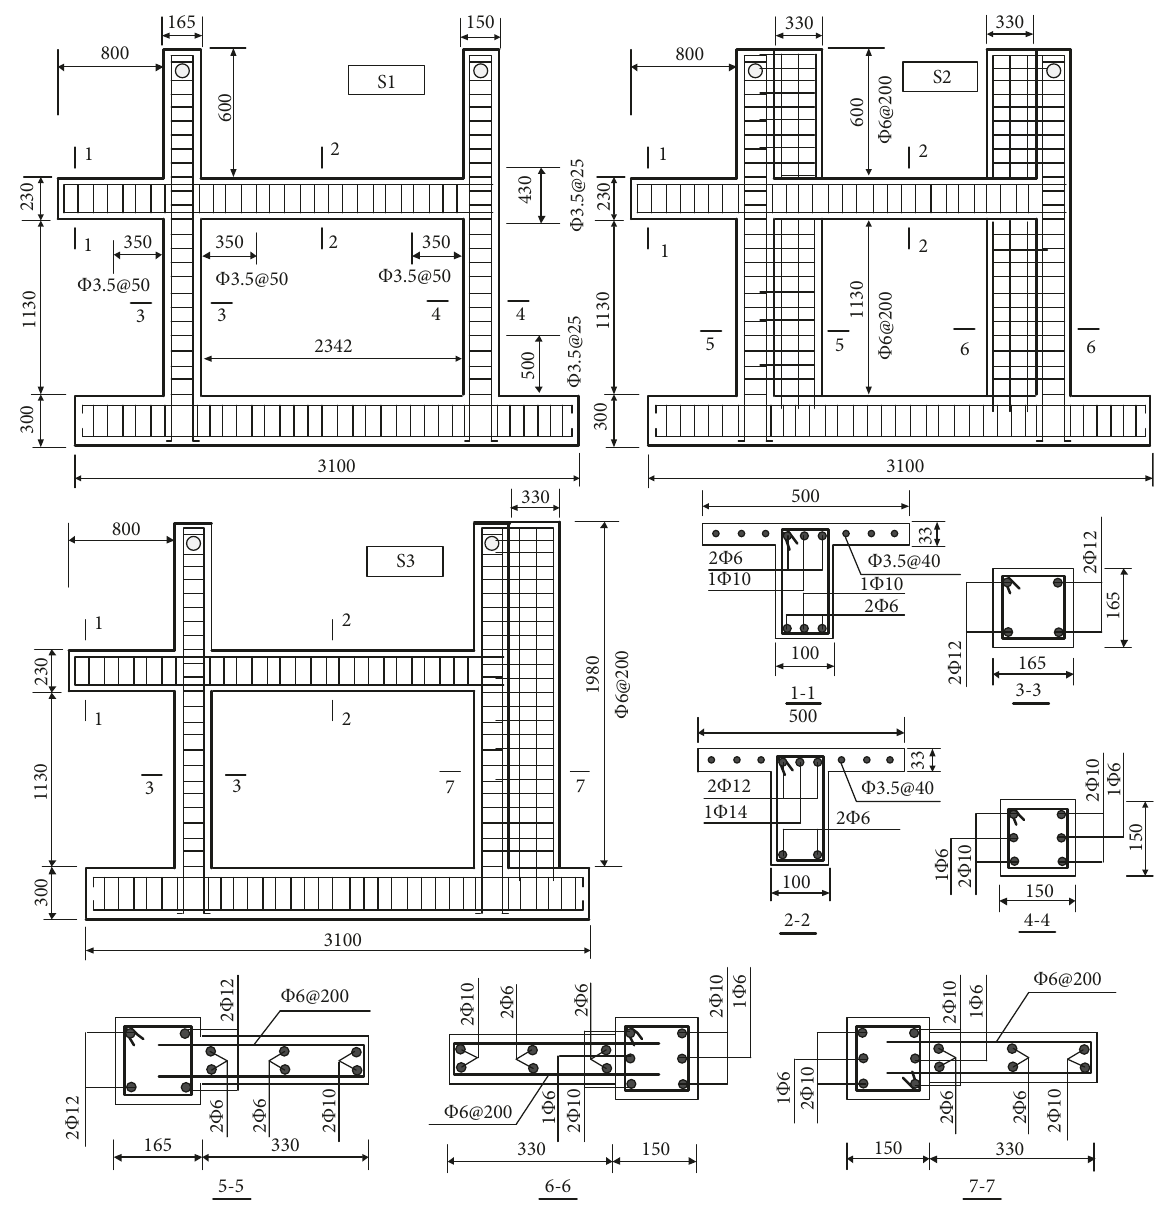
Figure 2: Dimensions and reinforcing details of